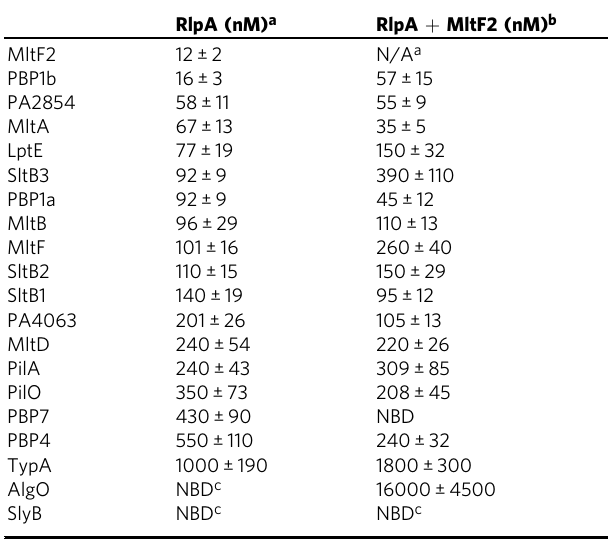
a Values denote the dissociation constants for the binary interactions. b Competition for binding to RlpA by two partner proteins. c NBD for “ no binding detected ” . RlpA- Δ 32 construct was used for this experiment. Data were presented as means±SD from triplicate